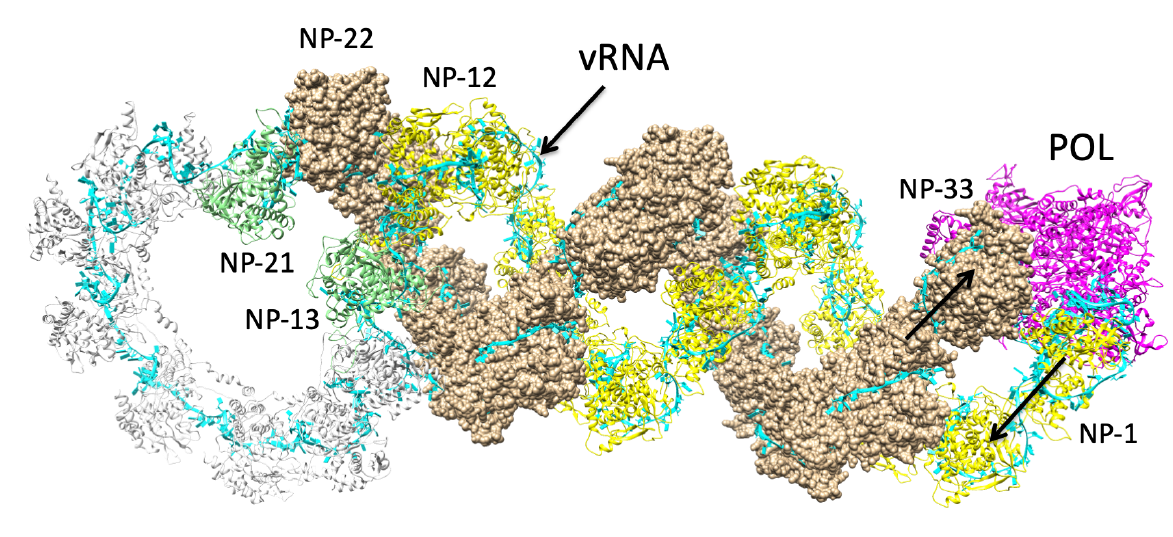
Figure 6. Structural model of the Influenza A NP–vRNA–polymerase (POL) complex. This model corresponds to the NS1 segment of the Influenza A /Albany/3/1967 RNP. Different NP oligomeric suprastructures are plotted as follows: helical NPs 1–12 (shown as yellow ribbons), circular NPs 13–21 (shown as gray ribbons), and helical NPs 22–33 (shown as tan calotte/space-filling). The vRNA (cyan) is plotted along the length of the RNP, and POL is shown in